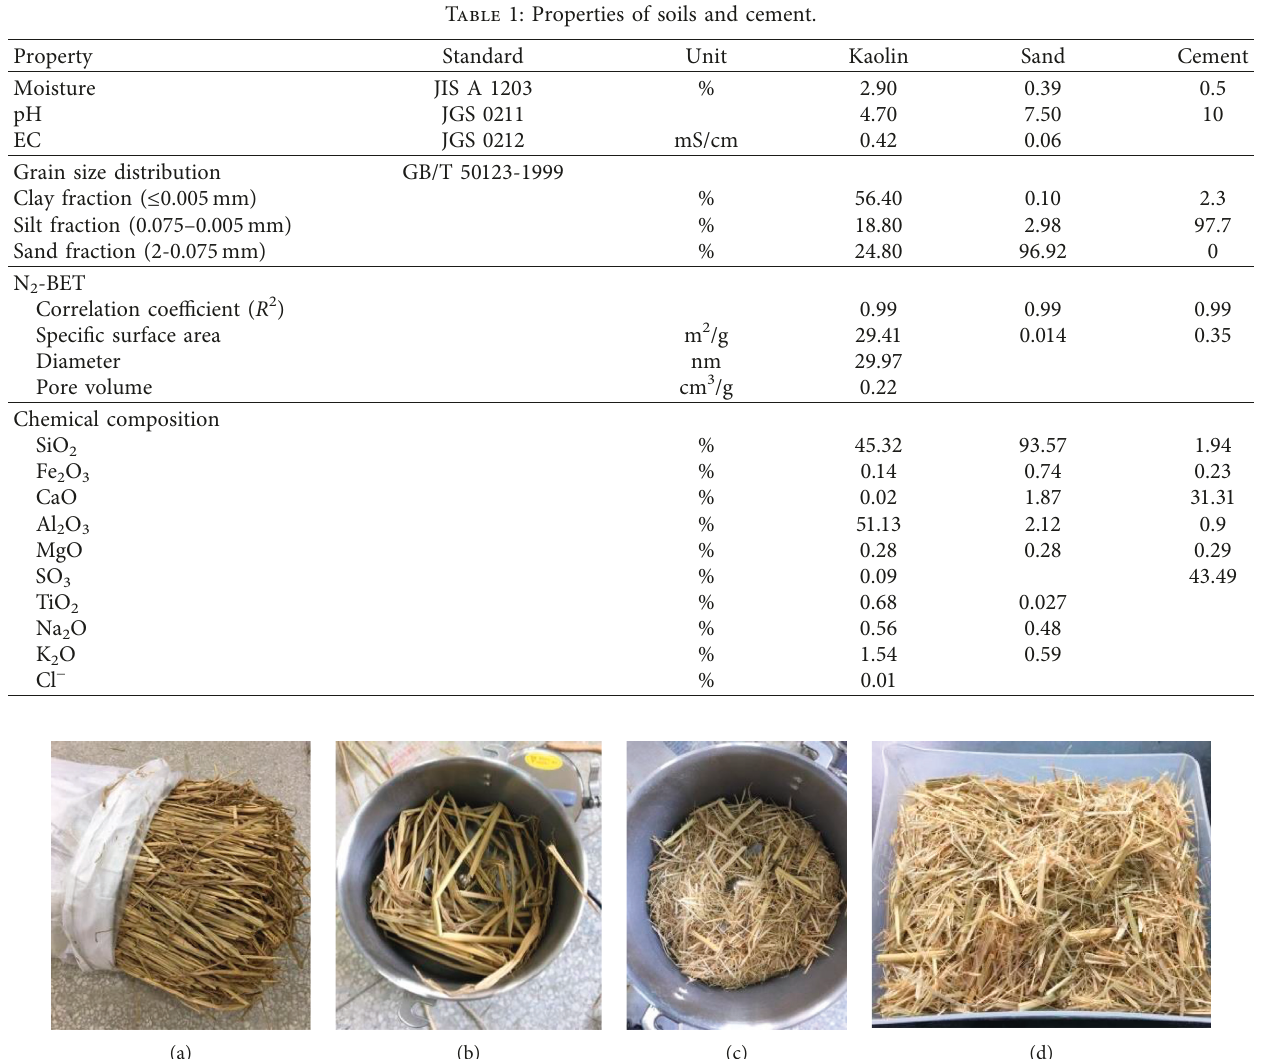
F IGURE 1: Pretreatment process of wheat straw. (a) Local wheat straw fibers. (b) Cleaned and dried fibers. (c) Milled fibers. (d) Fibers kept in a sealing